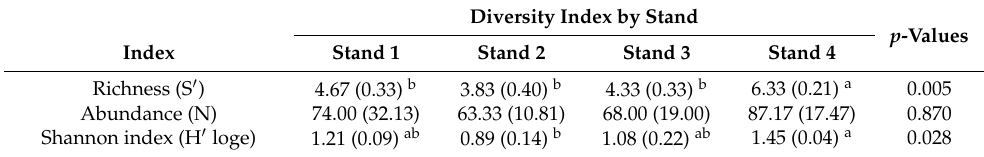
Table 5. Diversity indices for species in different stands in Kaw é sqar National Park. Diversity Index by